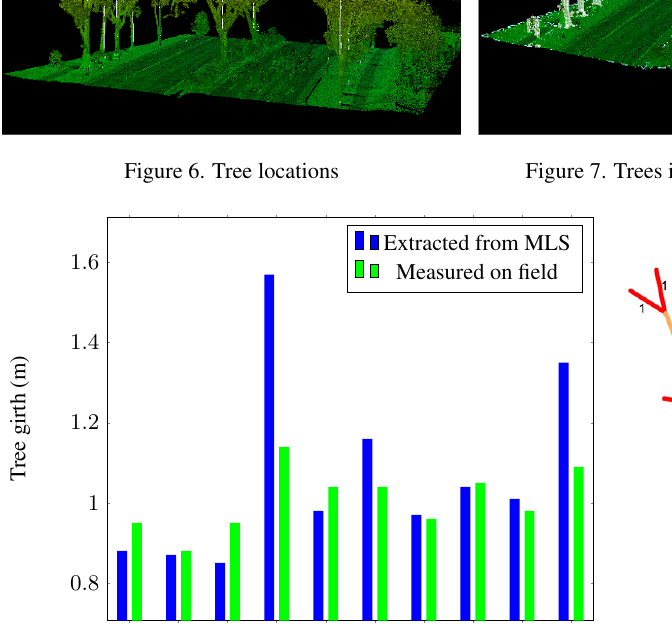
Figure 11. Diagrammatic view of XML structure storing branching